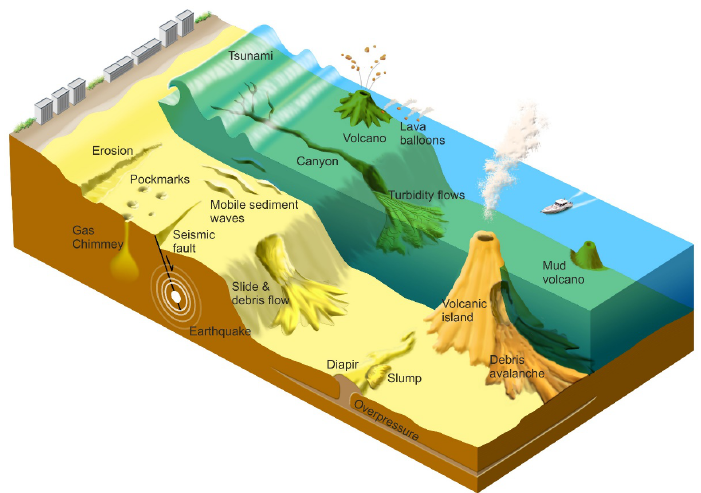
Figure 1. Sketch showing the main offshore geological hazards. Inspired by [7] .